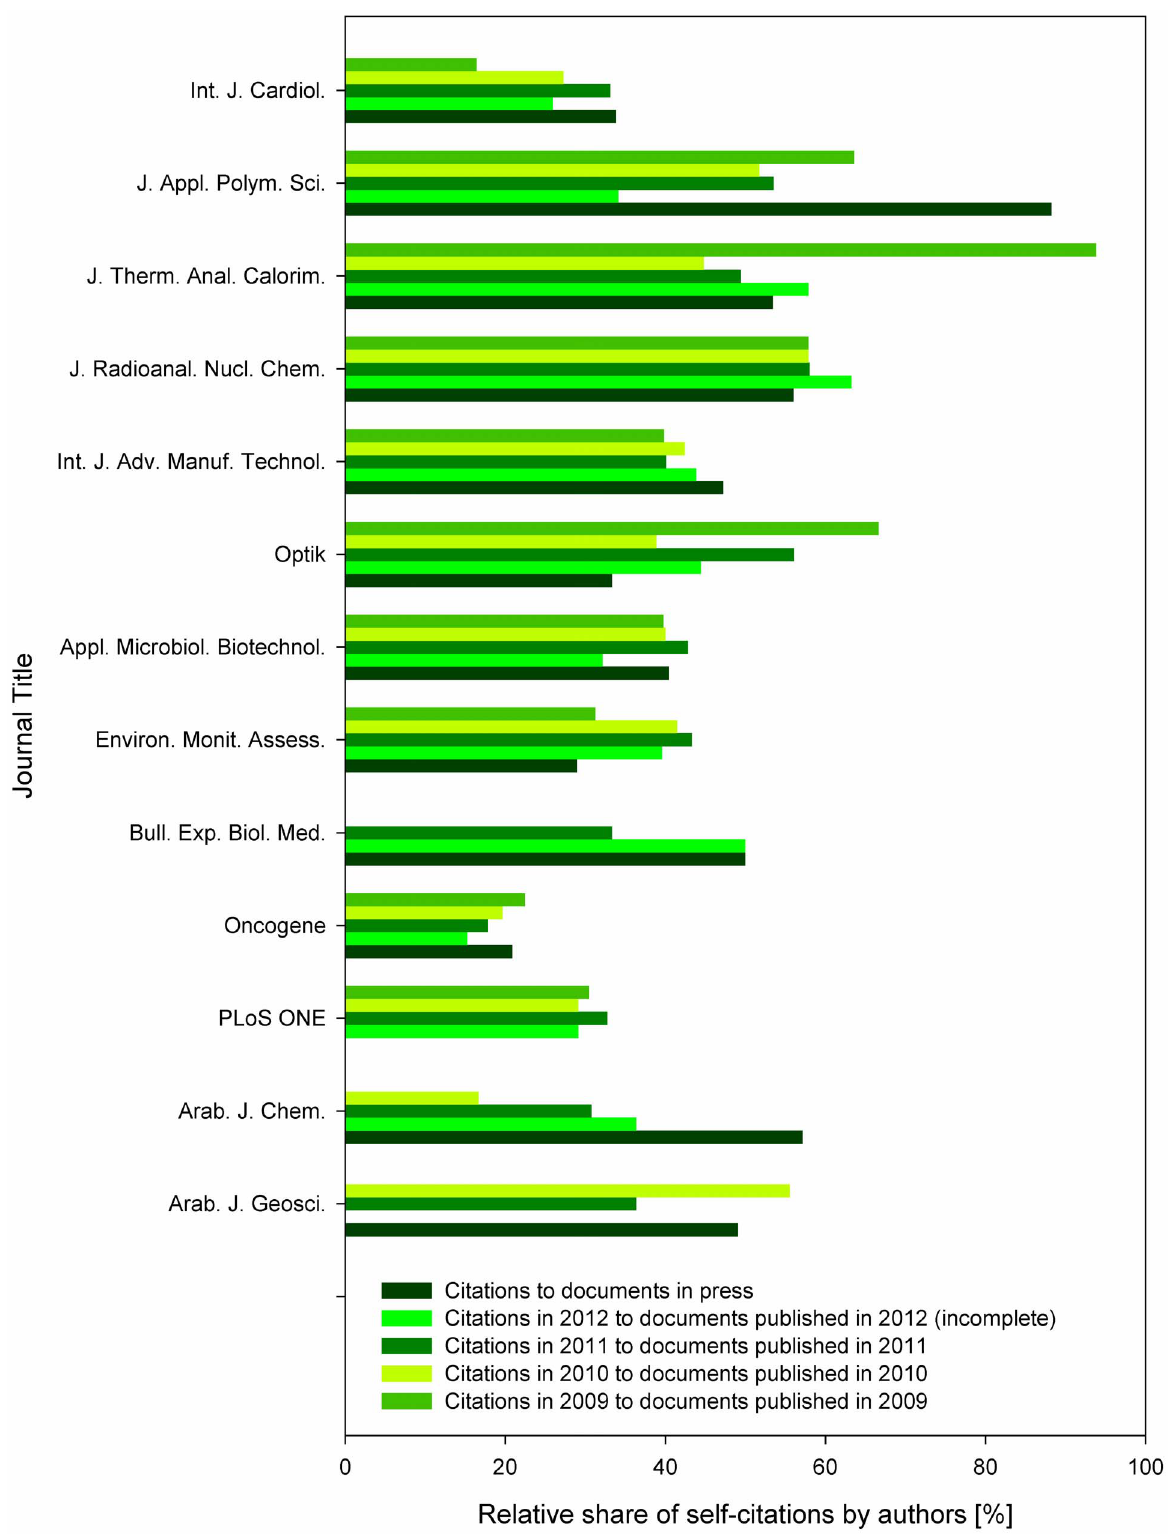
Figure 5. Relative share of authors’ self-citations. The data represent shares of citations, when at least one of the authors of a cited document was the same person as one of the authors of the citing document. Indicated are relative shares of authors’ self-citations among total citations to documents in press, and citations received within the year when the document was assigned to a journal issue (e.g., cites in 2009 to documents published in 2009; analyzed are documents published in 2009–2012). Zero values indicate absence of the source data in Scopus.